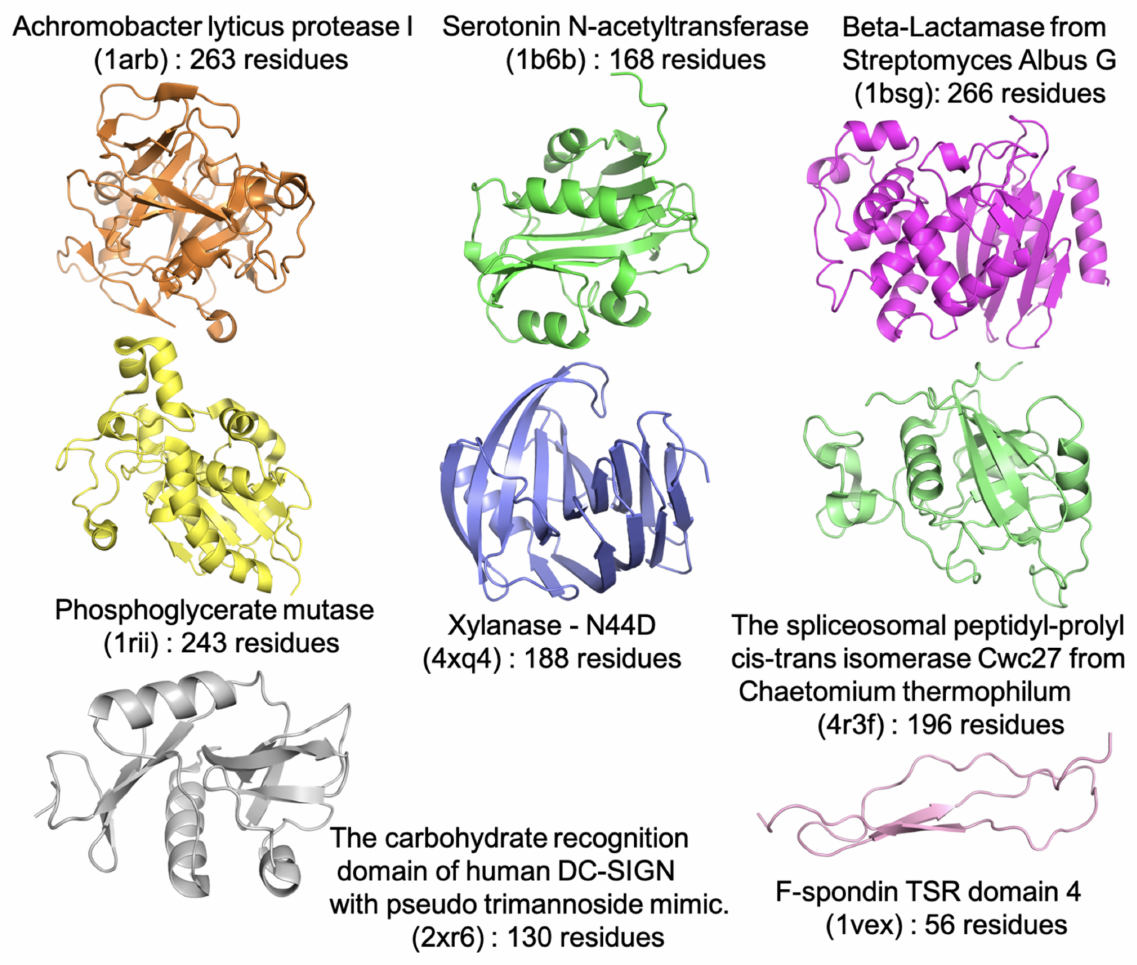
Figure 1. Seven folded proteins (PDB IDs: 1b6b [37], 1arb [38] 1bsg [39], 1rii [40], 2xr6 [41], 4r3f [42], and 4xq4 [43]) and one protein with intrinsically disordered regions (1vex [44]) simulated with polarizable and nonpolarizable force